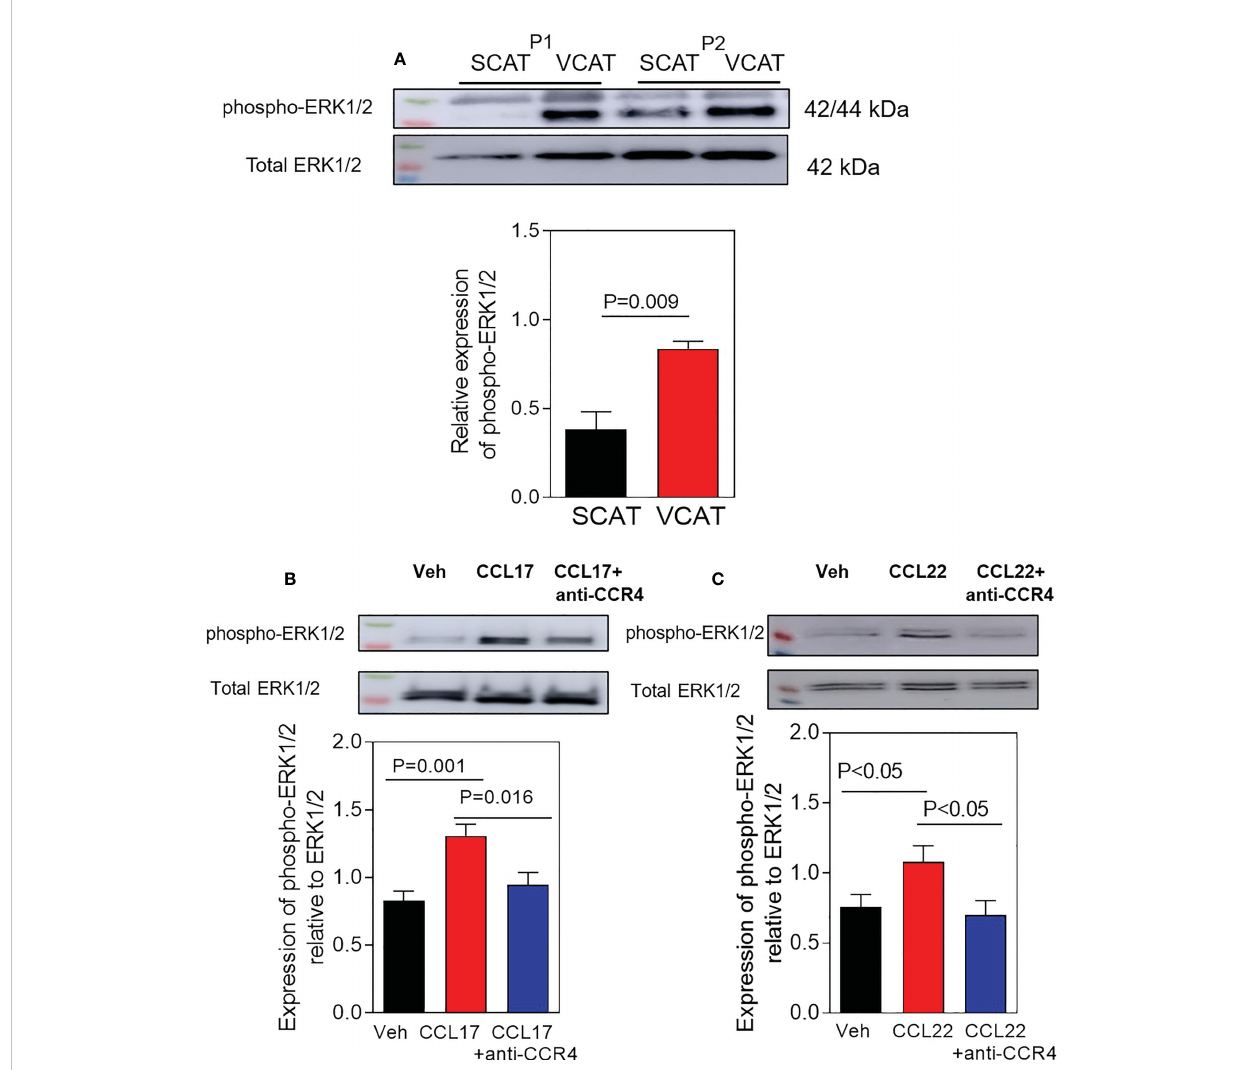
FIGURE 6 Activation of phospho-ERK1/2 MAPK signaling in VCAT from morbid obese patients. (A) Western blot analysis of phospho-ERK1/2 MAPK in paired SCAT and VCAT samples from morbid obese patients (P1-2). Representative Western blot is shown. Data represent the mean ± SEM of protein densitometry (n = 6). Comparisons between groups were made by two-tailed Student´s test. In additional experiments, HAEC were incubated with vehicle (B) , hrCCL17, or (C) hrCCL22 (10 ng/ml) for 30 minutes. Some cells were pre-treated with a mouse monoclonal blocking antibody